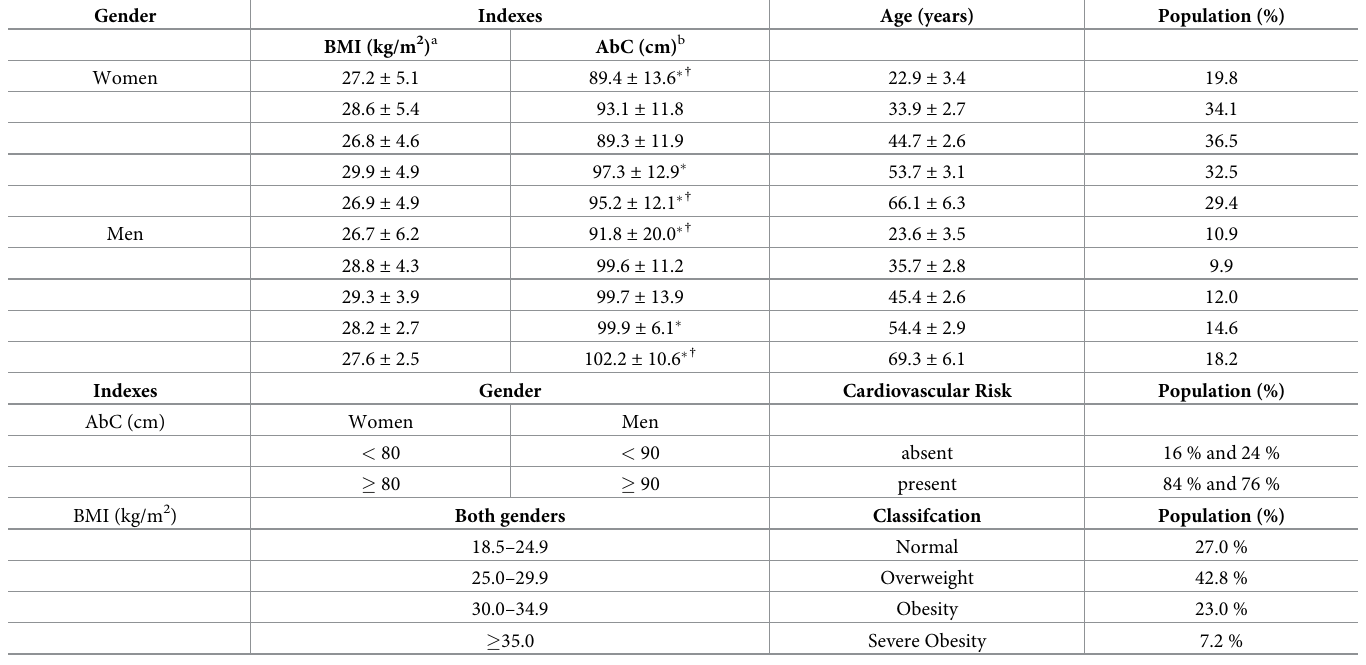
Table 2. Body mass index (BMI) and Abdominal Circumference (AbC) average values and risk classification for practitioners of Physical Education (PA). Sample stratified by age and gender: women (N = 192) e men (N =